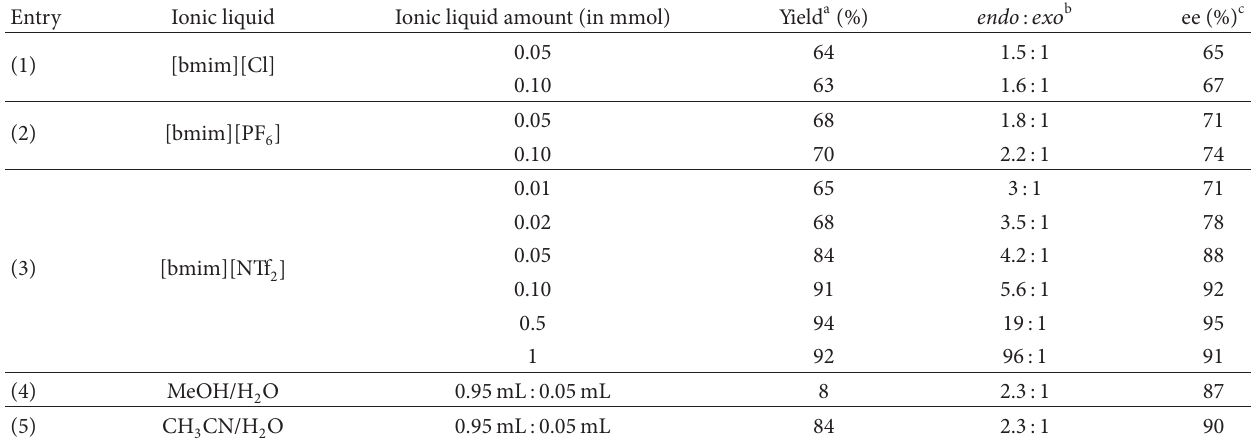
T 1: Screening of different ionic liquids for MacMillan’s imidazolidinone catalyst 1 catalysed Diels-Alder reaction between cyclohexene 1 and acrolein 2